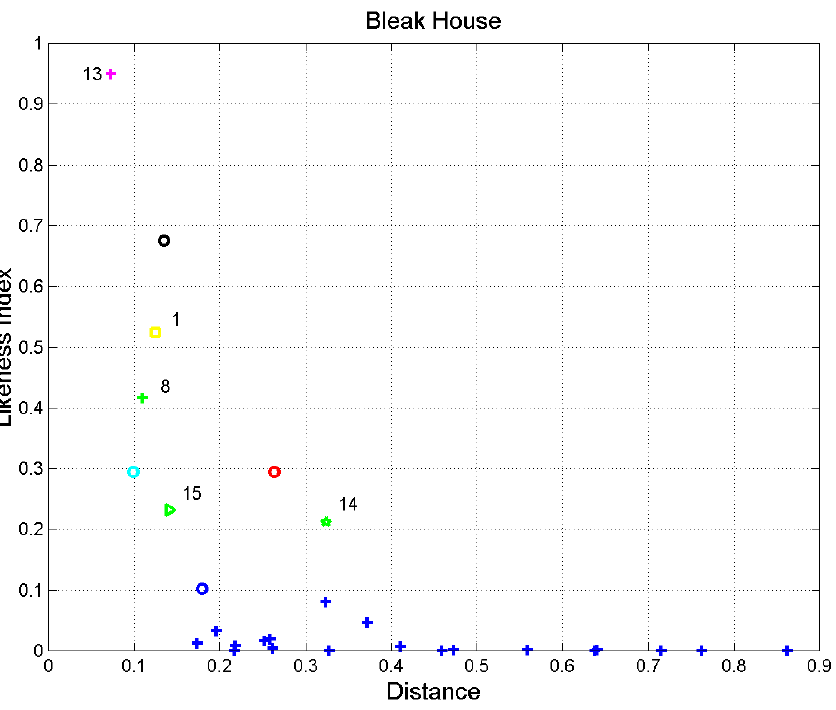
Figure 10. Likeness index 𝐼 𝐿 versus Pythagorean distance ℓ between a literary work and a reference (output) work ( Bleak House ).